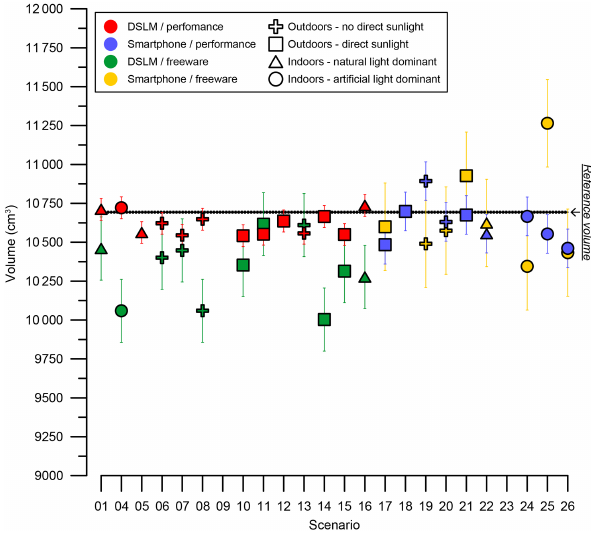
Figure 6. Performance- and freeware-workflow-derived SfM-MVS photogrammetric volumes of the artificial pit using a DSLM and a smartphone camera for different settings and lighting conditions. The reference volume (solid black line with dashed black error range) of 10693 ± 7cm 3 was measured by filling the empty flow- erpot with water and recording the difference in weight (assuming = 1gcm − 3 for demineralised water at ∼ 20 ◦ C water temper- ρ H 2 O